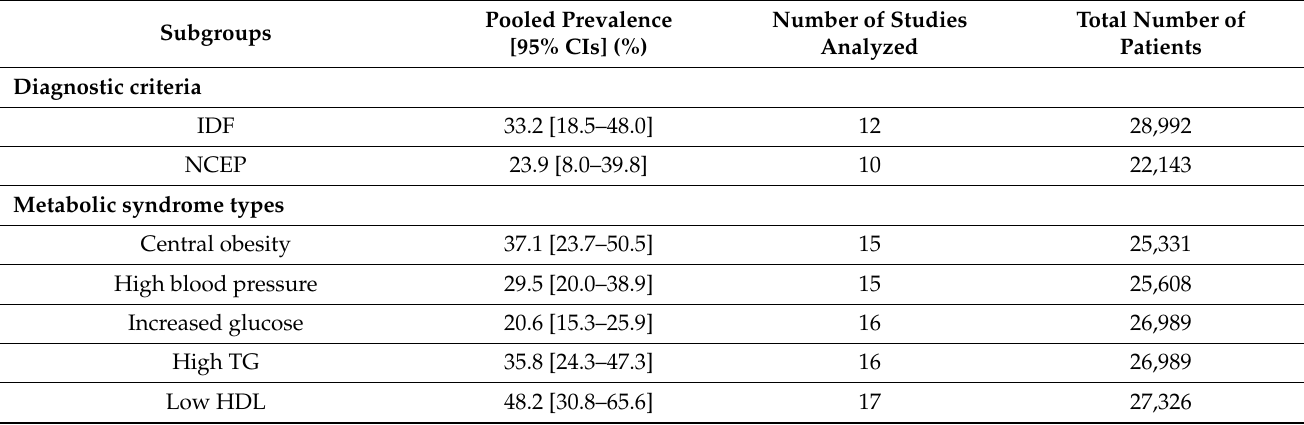
Table 2. Subgroup analyses estimating the pooled seroprevalence of metabolic syndrome in Pakistan.